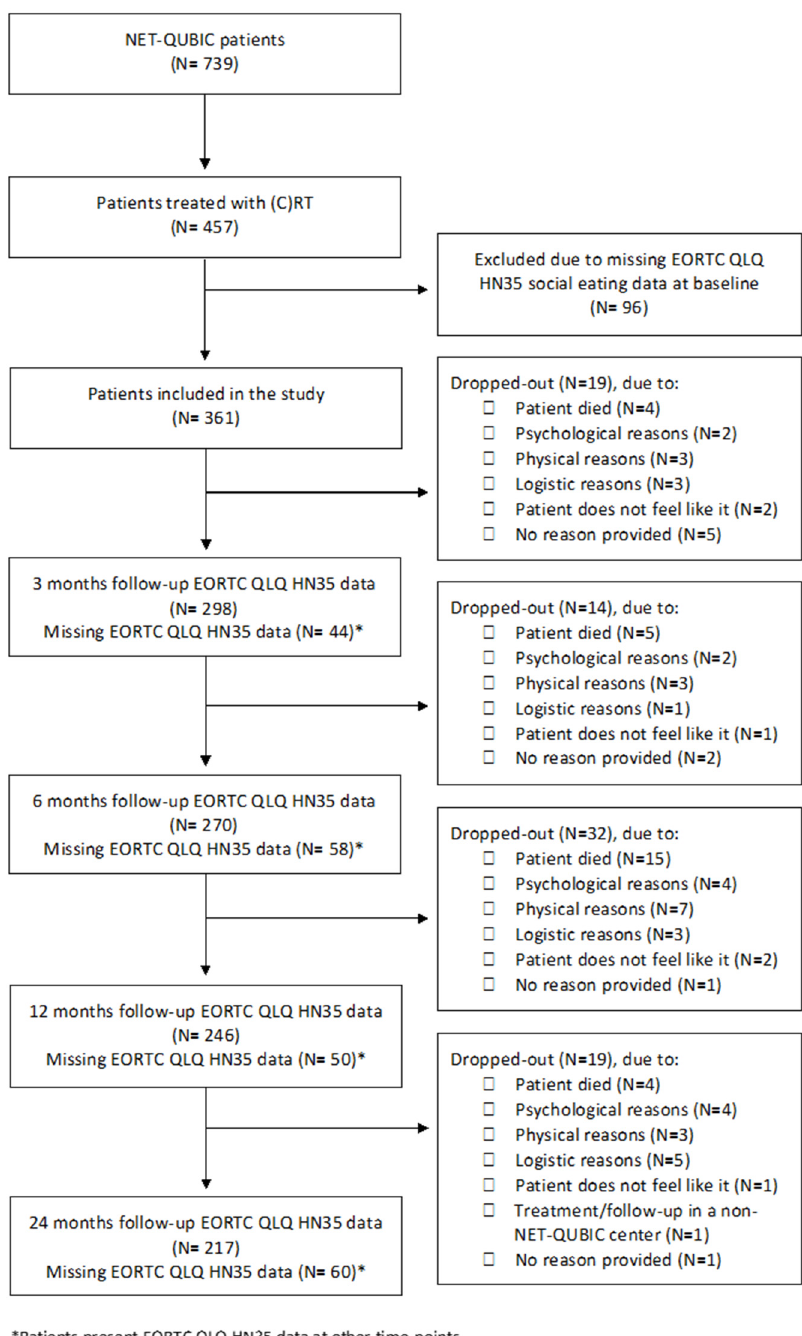
Figure 1. The study flow diagram, with reasons for exclusion at each time